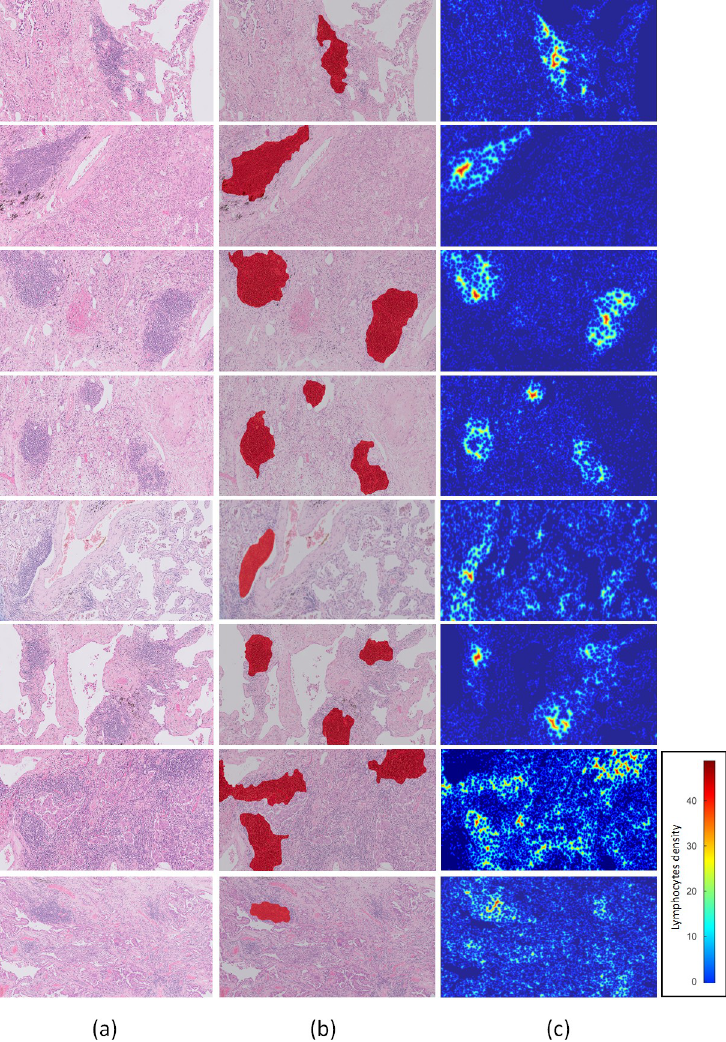
Fig 9. Identification of TLS regions and density of lymphocytes. a) input 10x H&E-stained image, b) detected TLS regions c) heat maps of lymphoyctes.